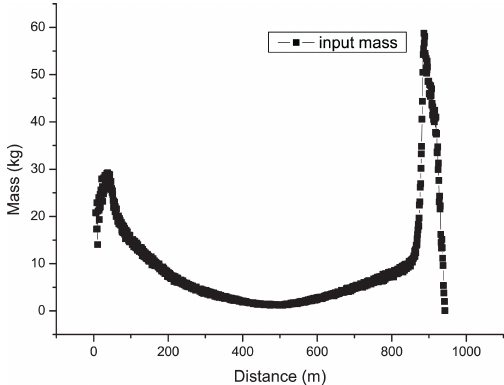
Figure 7. Dissolved salt over each element after 3years of simula- tion with 40m wide fault